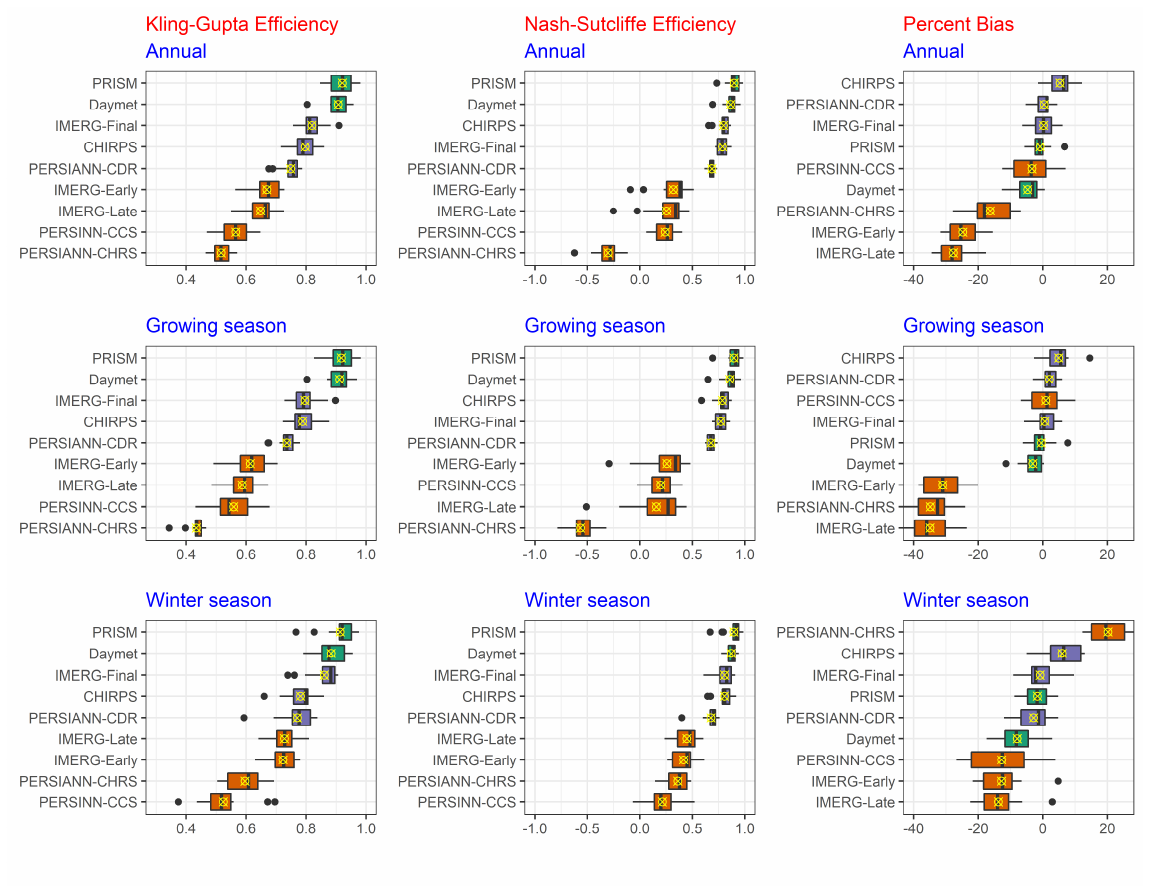
Figure 4. Point-to-grid monthly precipitation comparison statistics (2000–2019) for the Bosque watershed. These statistics were obtained by comparing observed monthly precipitation at an NCDC weather station against the estimated precipitation in the corresponding grid for a given gridded dataset. The yellow circle cross in the box denotes the mean, while the black vertical line in the box represents the median. Note: growing season June−October and winter season November−May.